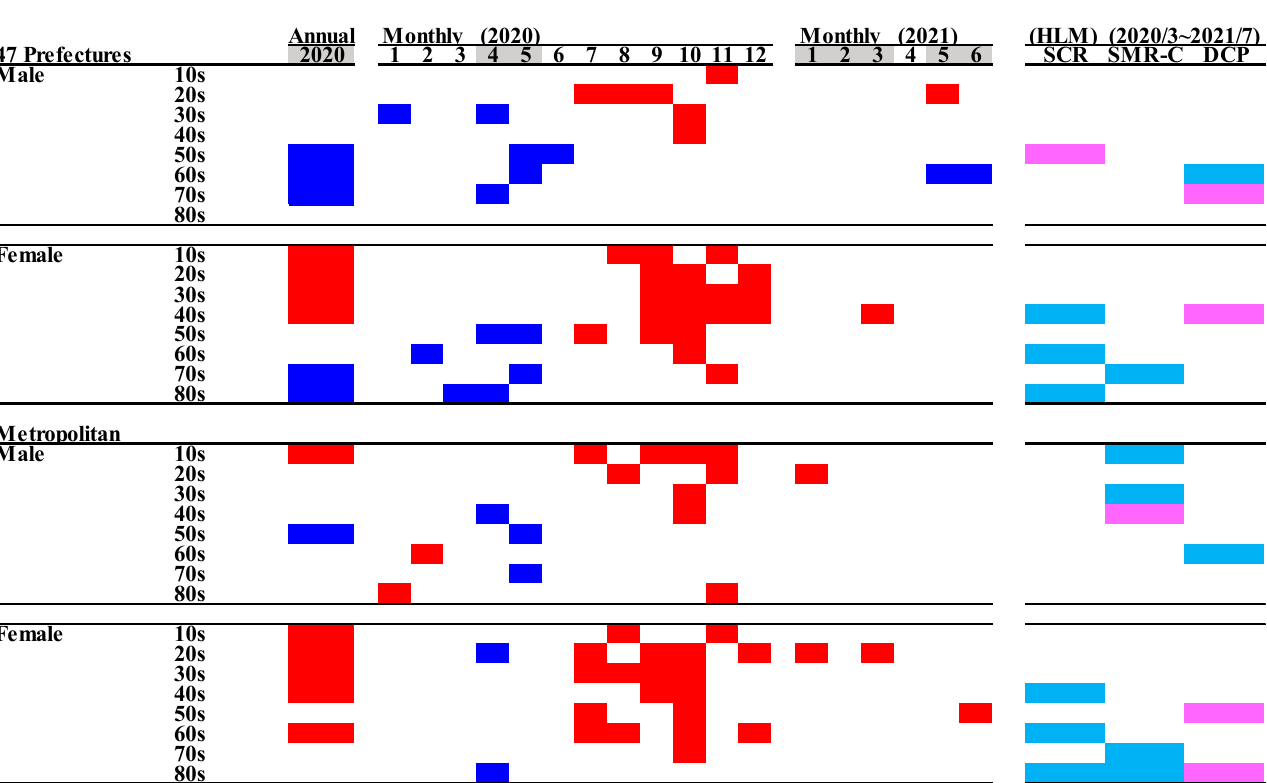
Figure 4. Temporal fluctuations in monthly SMR-S disaggregated by gender, age, and regional factors during the COVID- 19 pandemic period (2020–2021) compared to the average of SMR-S during the same month during the pre-pandemic period (2017–2019). Dotted black, red, and blue lines indicate the average of SMR-S for ( A ) males from all 47 prefectures, ( B ) males from metropolitan regions, ( C ) females from all 47 prefectures, and ( D ) females from metropolitan regions. Ordinates indicate the SMR-S (per 100,000 people), and abscissas indicate the month. * p < 0.05, significant change using a linear mixed-effects model with Tukey’s multiple comparison. Red and blue asterisks indicate significant changes in SMR- S in 2020 and 2021, respectively, compared to the average SMR-S of the same month during the pre-pandemic period.